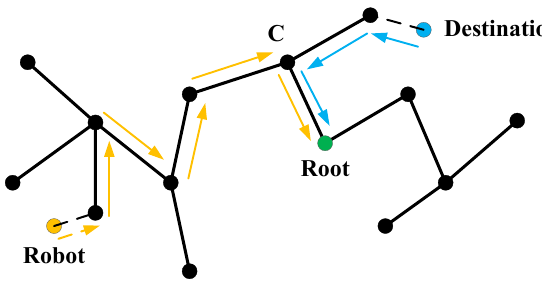
Figure 9. Search a feasible path.